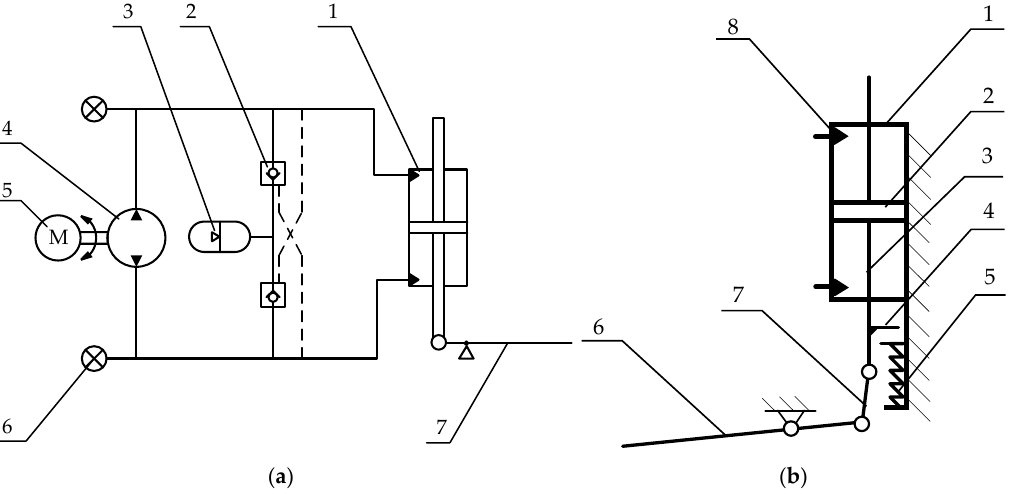
Figure 1. Schematic of the powered ankle prosthesis. ( a ) The hydraulic circuit diagram: 1: hydraulic cylinder; 2: check valve; 3: accumulator; 4: gear pump; 5: brushless DC motor; 6: pressure sensor; 7: sole; 8: link bar; 9: unidirectional spring. ( b ) The mechanical schematic: 1: hydraulic cylinder; 2: piston; 3: piston rod; 4: shaft shoulder on piston rod; 5: unidirectional spring; 6: sole; 7: link bar; 8: piping to the oil supply unit.